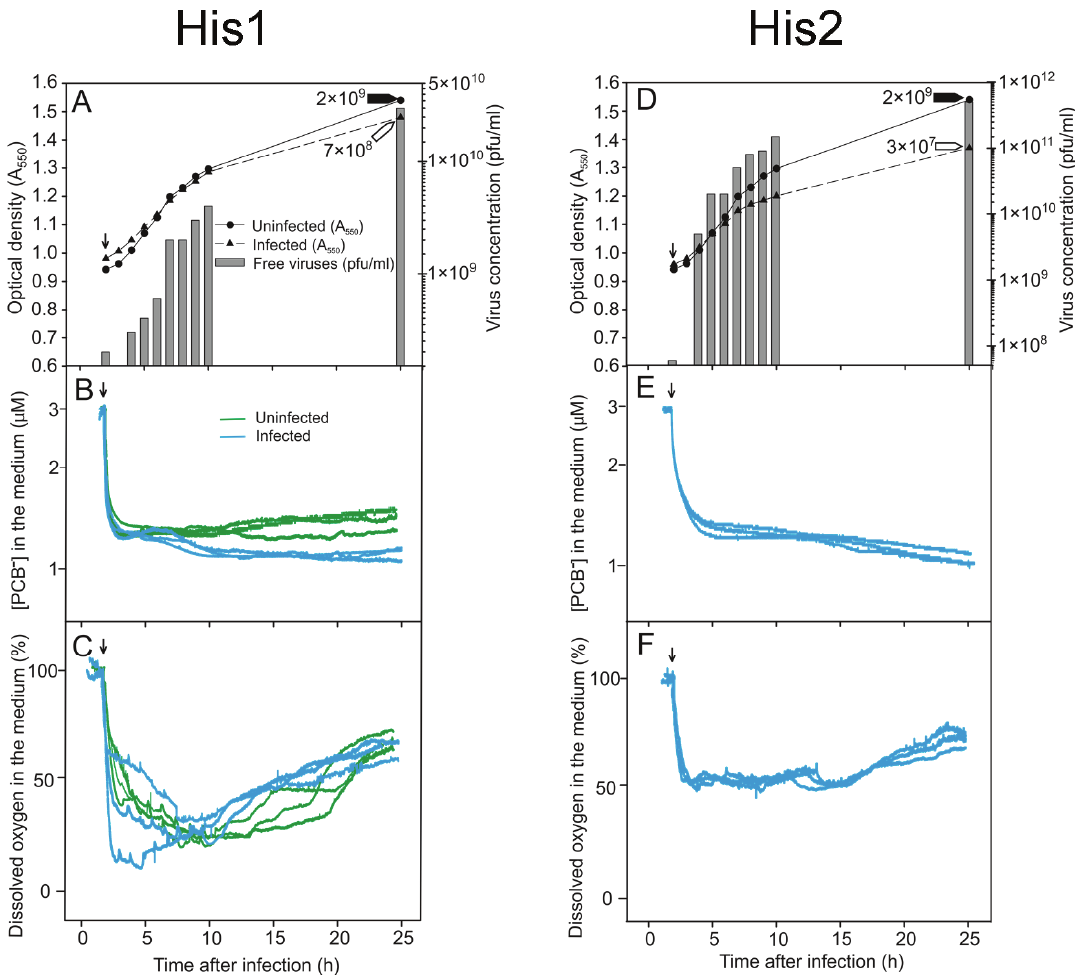
Figure 3. Growth parameters and physiological changes in Haloarcula hispanica during ( A – C ) His1 and ( D , F ) His2 virus infection (MOI of 20). For PBC − binding and oxygen consumption for the uninfected and heat disrupted control cells, see Figure 2A–C.